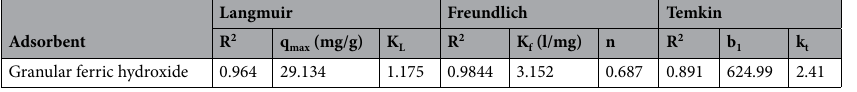
Table 7. The parameters of isotherm models for AR18 adsorption.